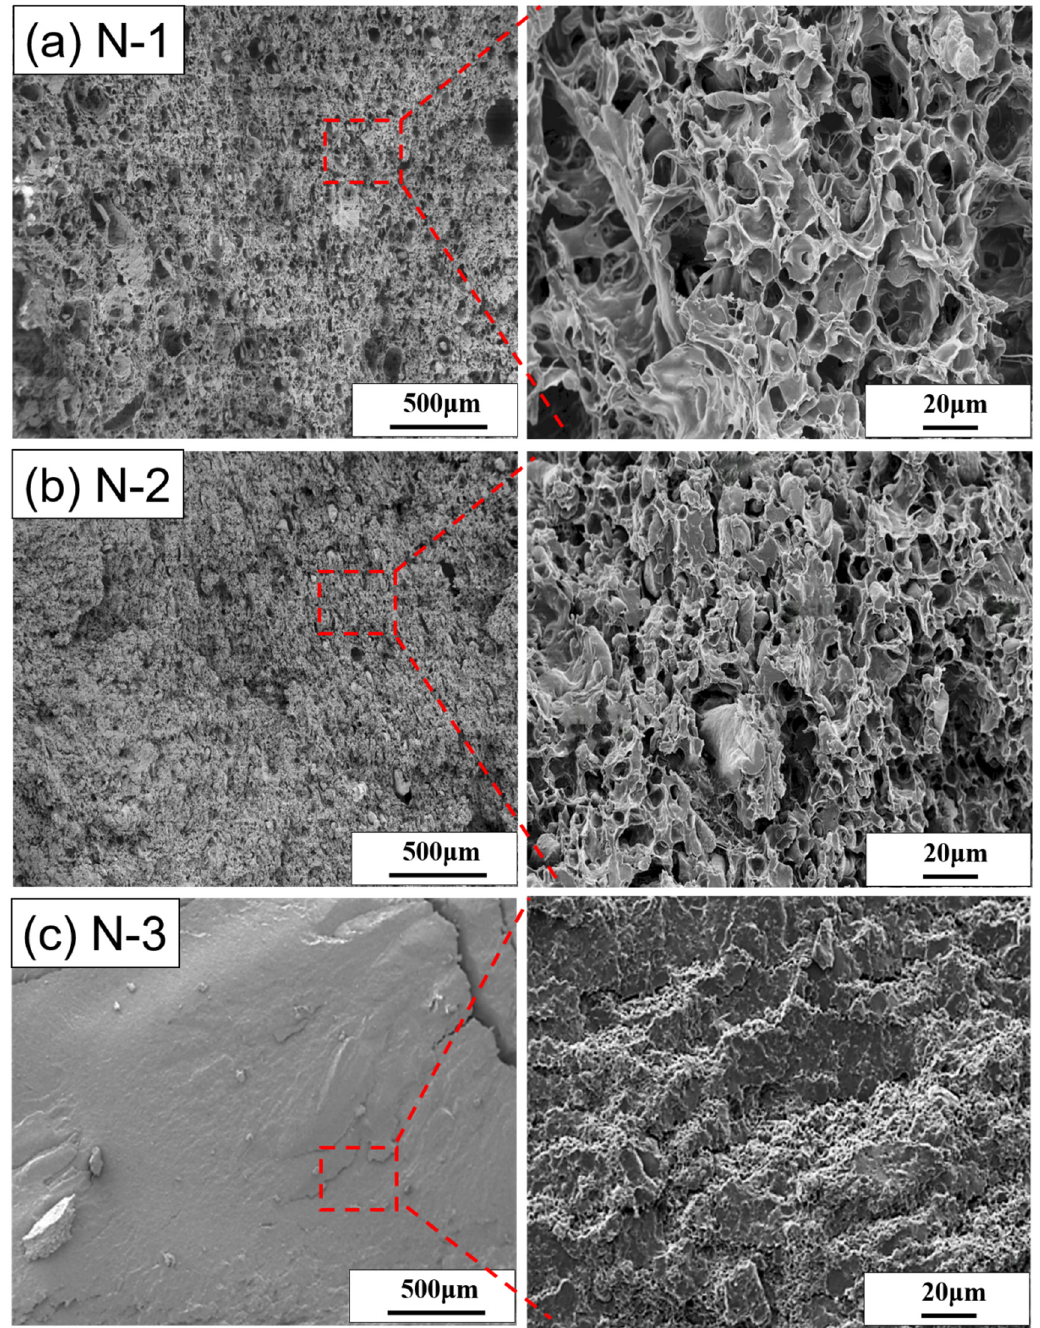
Figure 5. The SEM images of cell structure ( a ) [N-1], ( b ) [N-2], and ( c ) [N-3] at the foaming temperature of 95 °C and the foaming pressure of 17 MPa.